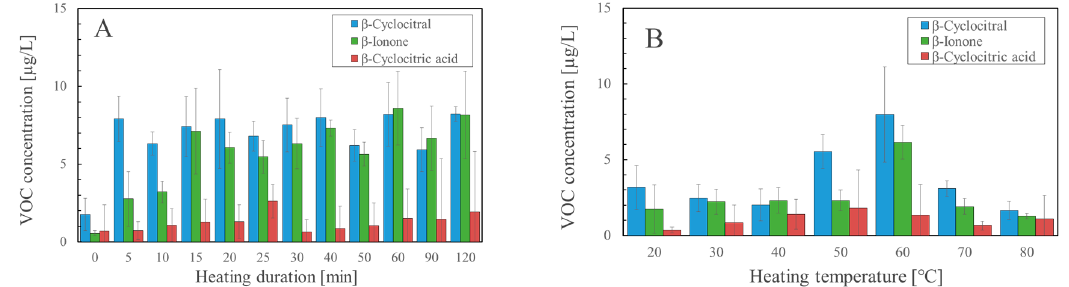
Figure 2. Optimization of heating conditions for detection of β -cyclocitral by the modified solvent extraction ( n = 3). ( A ) Heating duration, ( B ) Heating temperature.